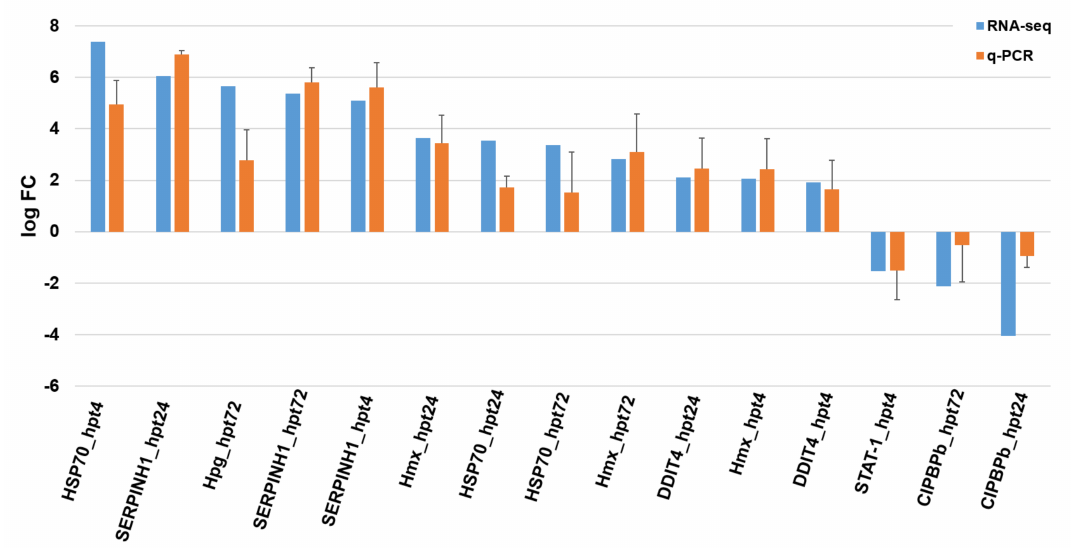
Figure 4. Comparison of gene expression levels between RNA-sequencing and qPCR